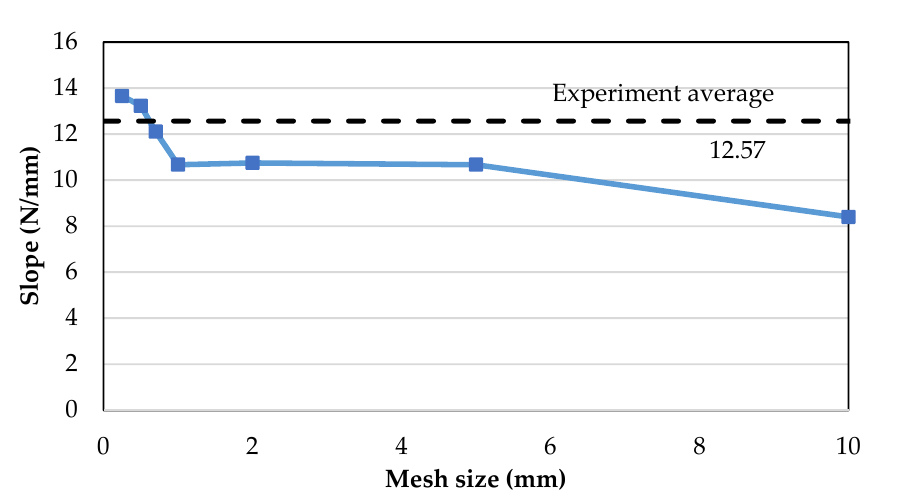
Figure 4. Mesh size effect on Mode-I load–displacement curves. Figure 4. Convergence from coarser to a finer